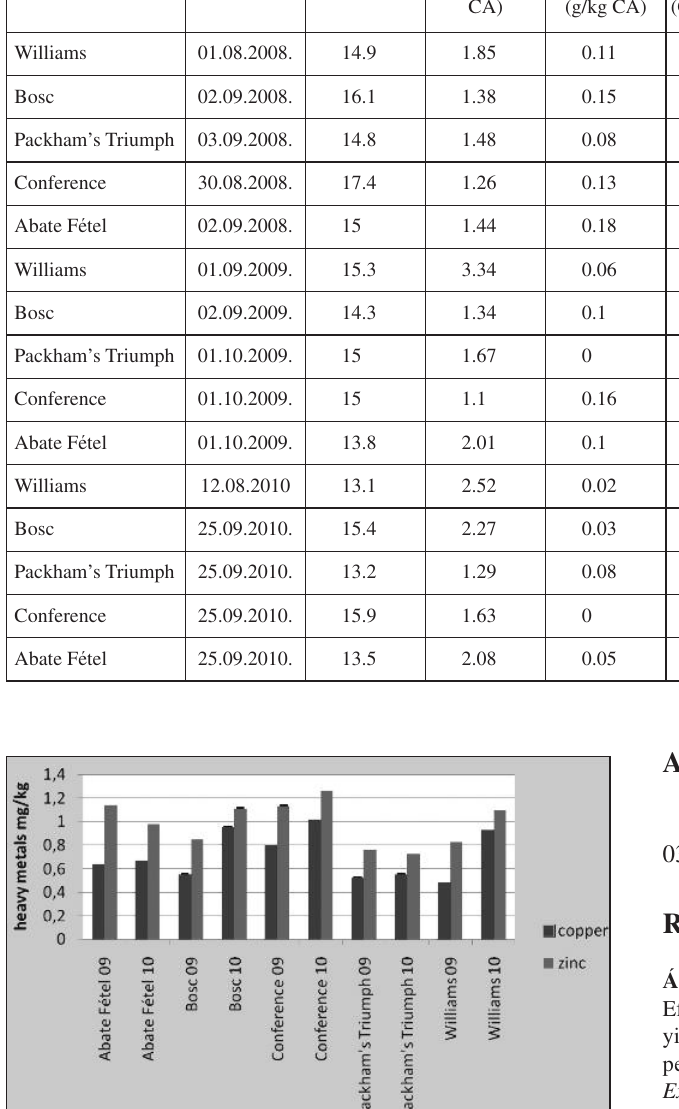
Table 4: Characteristics of pear cultivars in 2008-2010 period